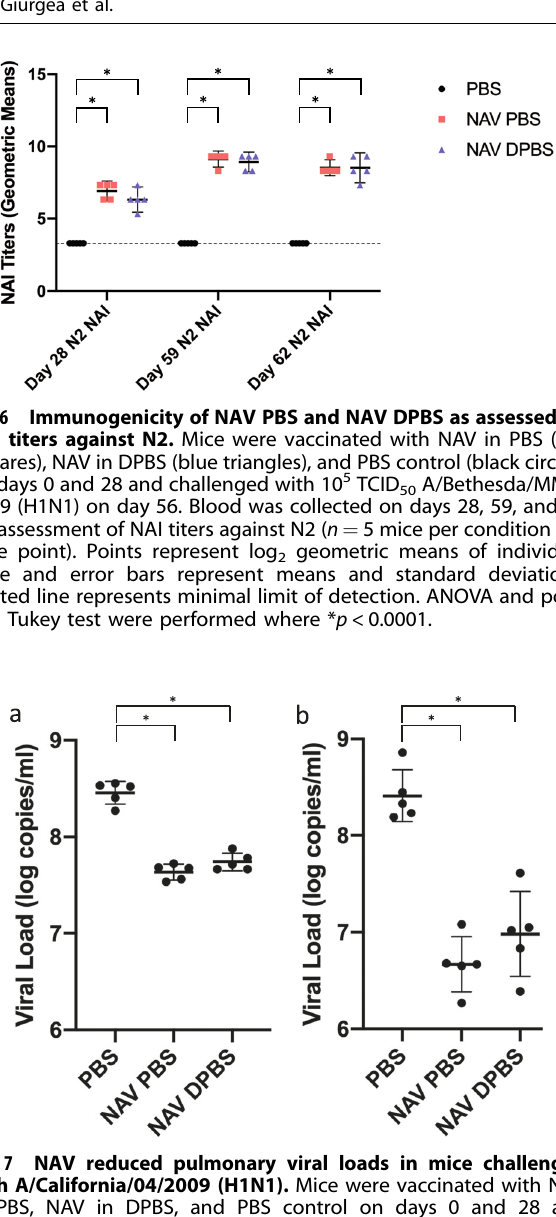
vaccination, NAV PBS mice had − 0.822 log copies/ml (95% CI, − 0.989 to − 0.655, p < 0.0001) compared to PBS mice while NAV DPBS mice had − 0.716 log copies/ml (95% CI, − 0.883 to − 0.549, p < 0.0001) compared to PBS mice. Six days after vaccination, NAV PBS mice had − 1.742 log copies/ml (95% CI, − 2.316 to − 1.168, p < 0.0001) compared to PBS mice while NAV DPBS mice had − 1.430 log copies/ml (95% CI, − 2.004 to − 0.856, p < 0.0001) mice vaccinated with NAV PBS and those vaccinated with NAV DPBS at either day 59 or day 62 (Supplemental Tables 10, 11).